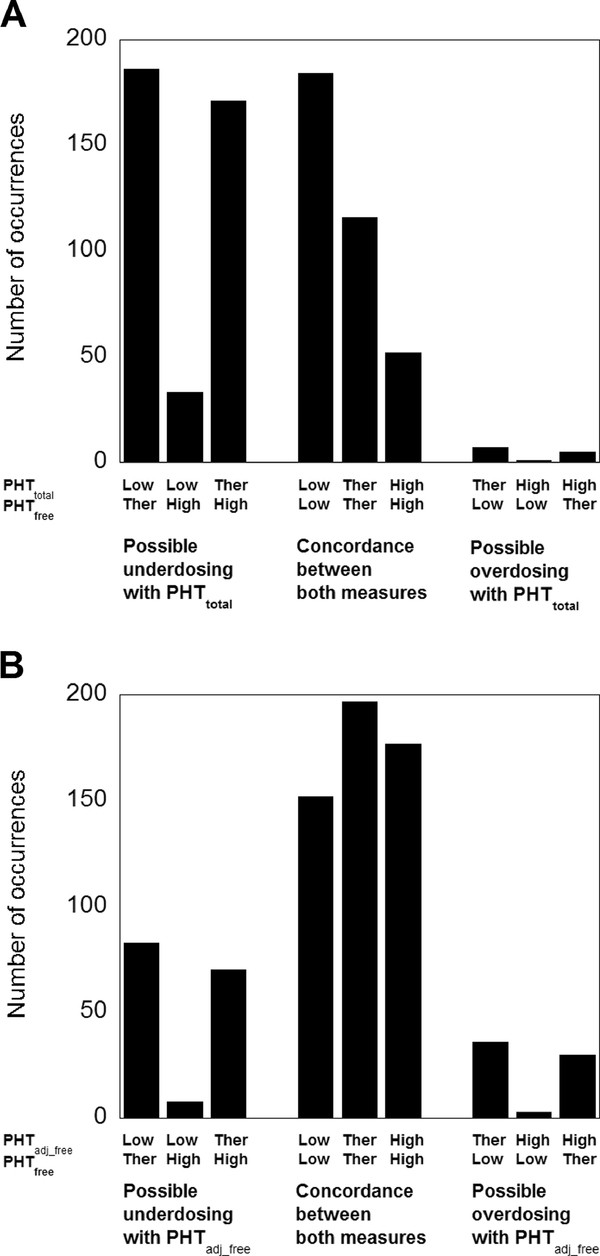
Clinical decision using total phenytoin or adjusted phenytoin compared to measured free phenytoin. (A) The data is derived from three-by-three contingency tables comparing grouping of PHTtotal and PHTfree into lower than therapeutic reference range (L), within therapeutic reference range (T), and higher than therapeutic reference range (H). For the three bar graphs on the left, PHTtotal would tend to lead to underdosing relative to the PHTfree. For the three bar graphs in the center, PHTtotal and PHTfree are concordant. For the three bar graphs on the left, PHTtotal would tend to lead to overdosing relative to PHTfree. For patients who had multiple phenytoin measurements, only the chronologically first set of concentrations available is plotted. The data is from 756 patients. (B) Similar design as in (A) except that PHTadj_free (using the Sheiner-Tozer equation) is compared to PHTfree. The data is from 756 patients